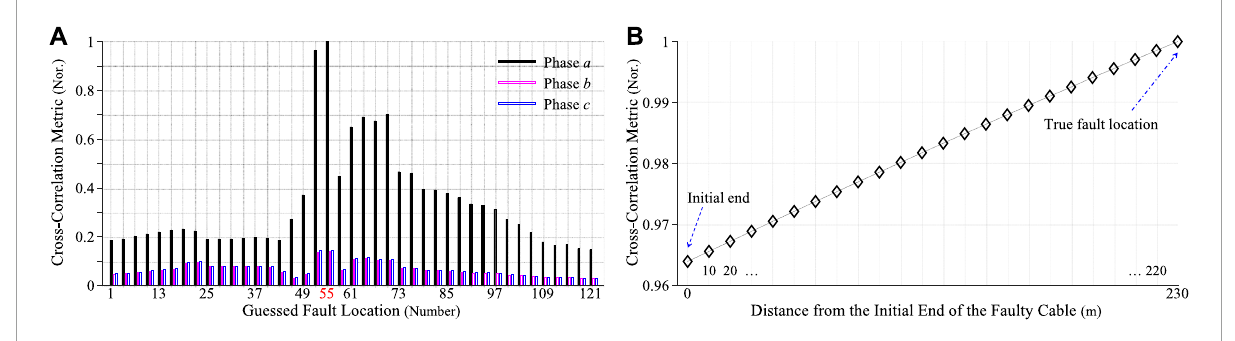
FIGURE 6 Normalized cross-correlation metric calculated for the solid phase ( a )-to-ground fault in the pilot test as a function of (A) the guessed fault location and (B) the distance from the initial end (i.e., the guessed fault location numbered 52) of the 230-m faulty cable. The true fault location is numbered